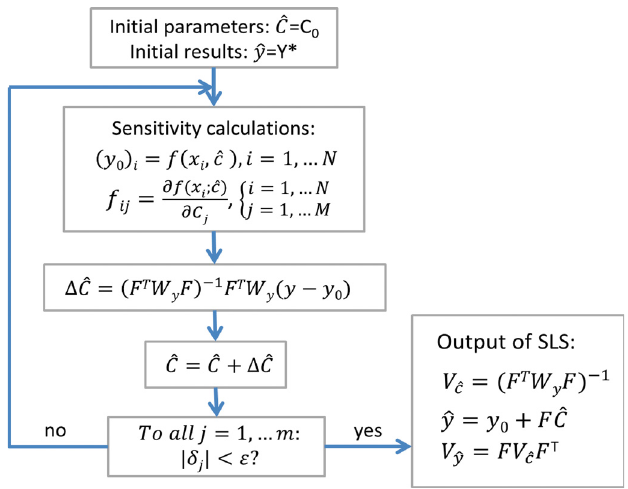
Fig. 1. The fl ow chart of conventional